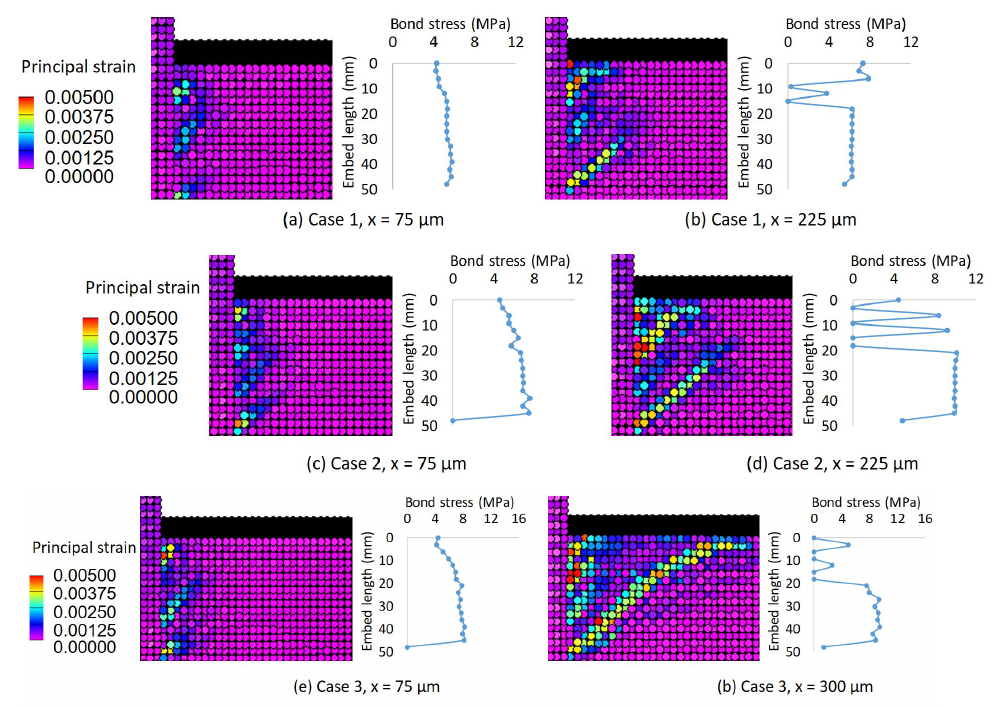
Figure 12. Crack development and bond stress distribution. ( a , b ) Case 1. ( c , d ) Case 2. ( e , f ) Case 3.